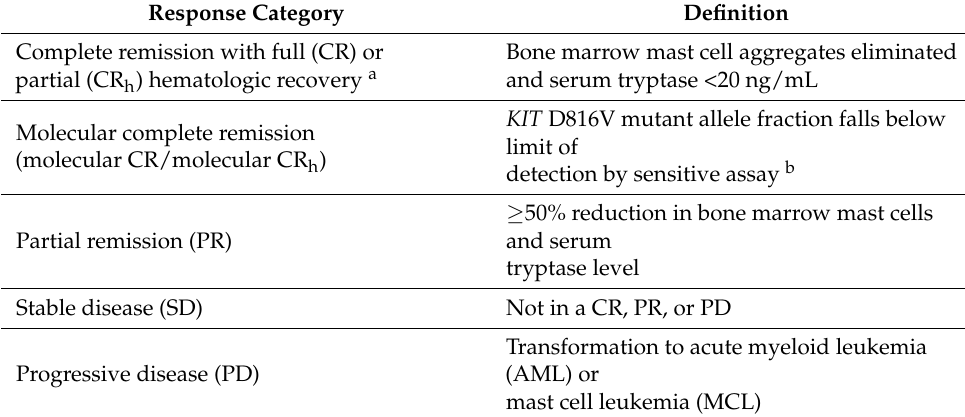
Table 4. Pure Pathologic Response (PPR)